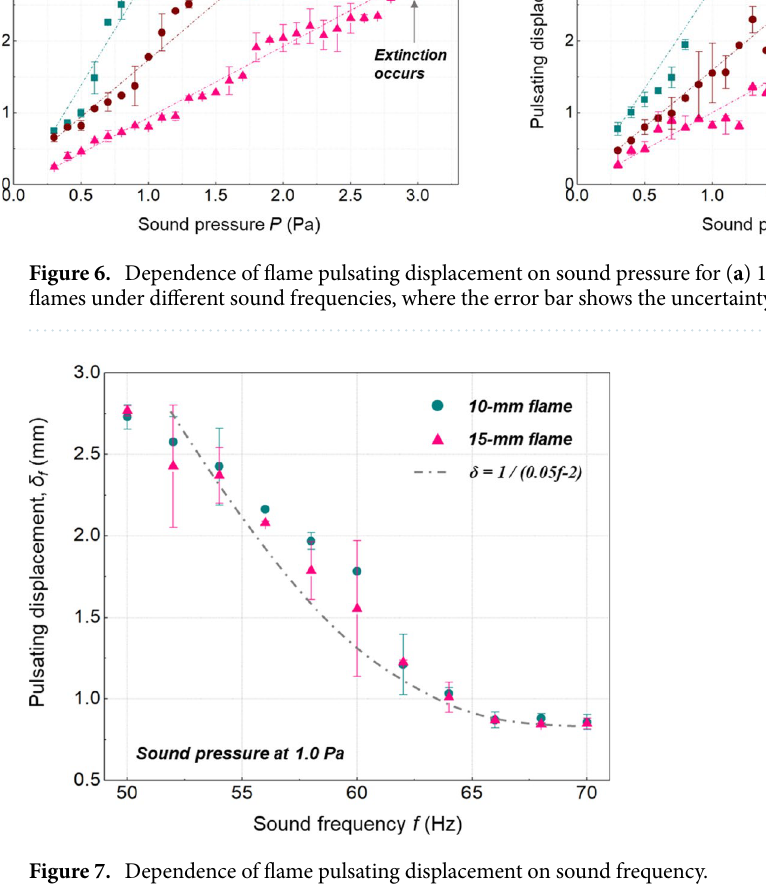
Figure 7. Dependence of flame pulsating displacement on sound